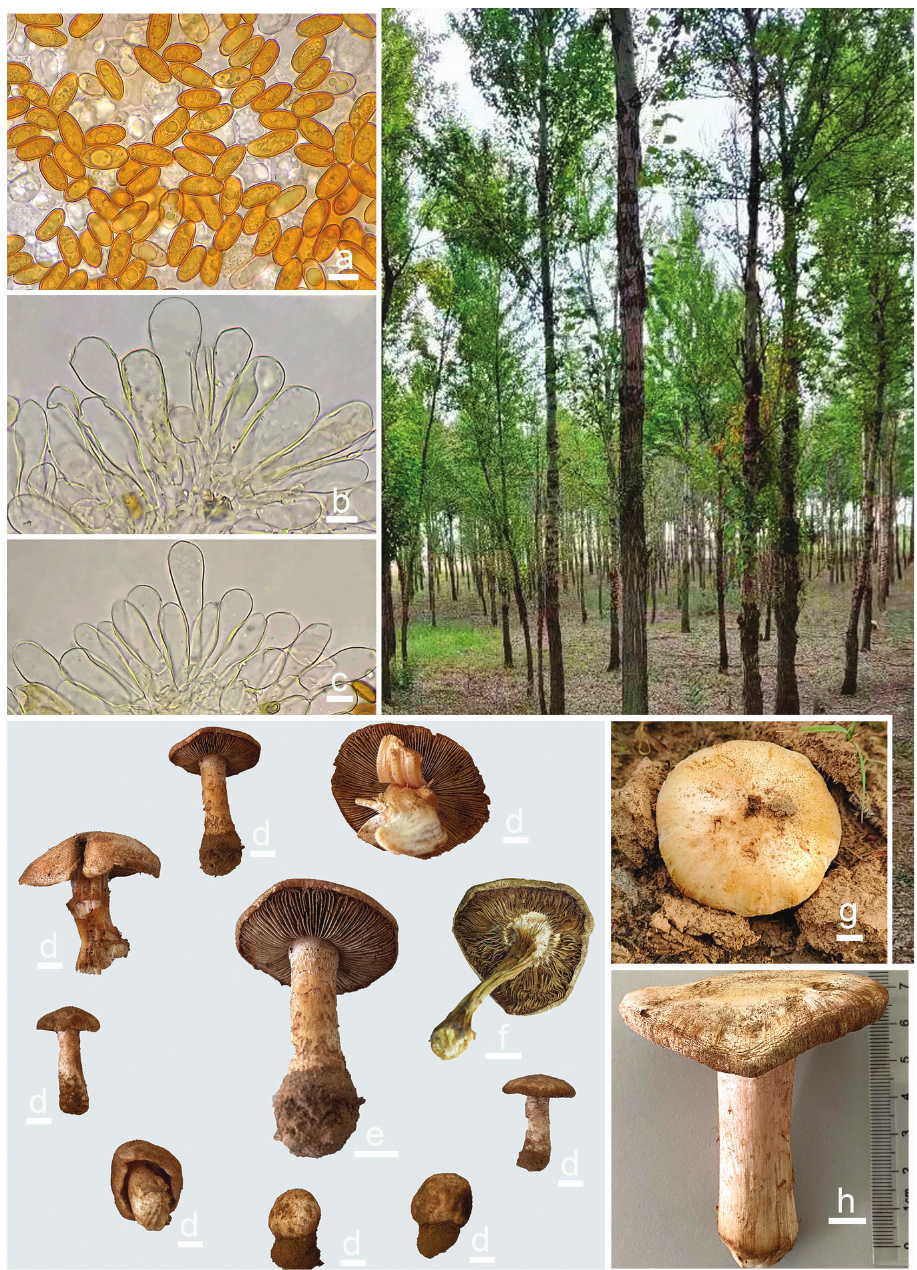
Figure 2. Pseudosperma arenarium and its habitat a basidiospores b, c cheilocystidia d–h basidiomata. Scale bars: 10 μm ( a–c ); 10 mm ( d–h ). Photos by Xu Fei, Li Hai-Jiao & Zhao